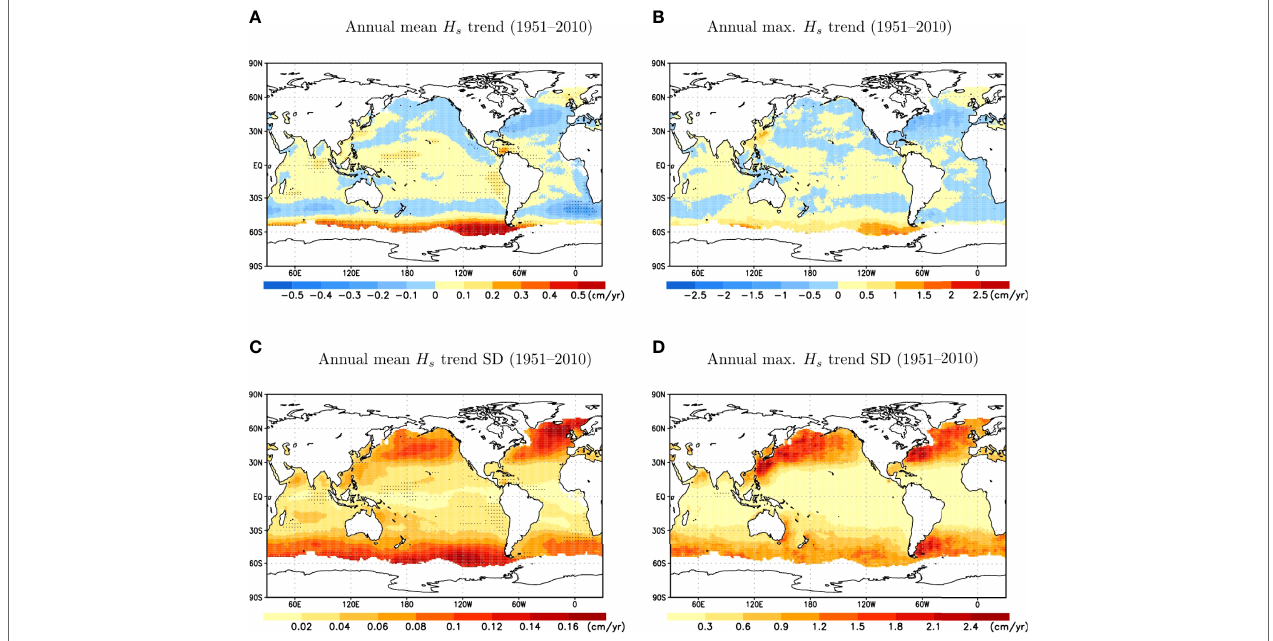
FIGURE 2 | Ensemble average (A, B) and standard deviation (C, D) of the annual mean H s (A, C) and maximum H s (B, D) trend (cm/yr) for 1951–2010. Stippling indicates the ensemble mean trend is statistically